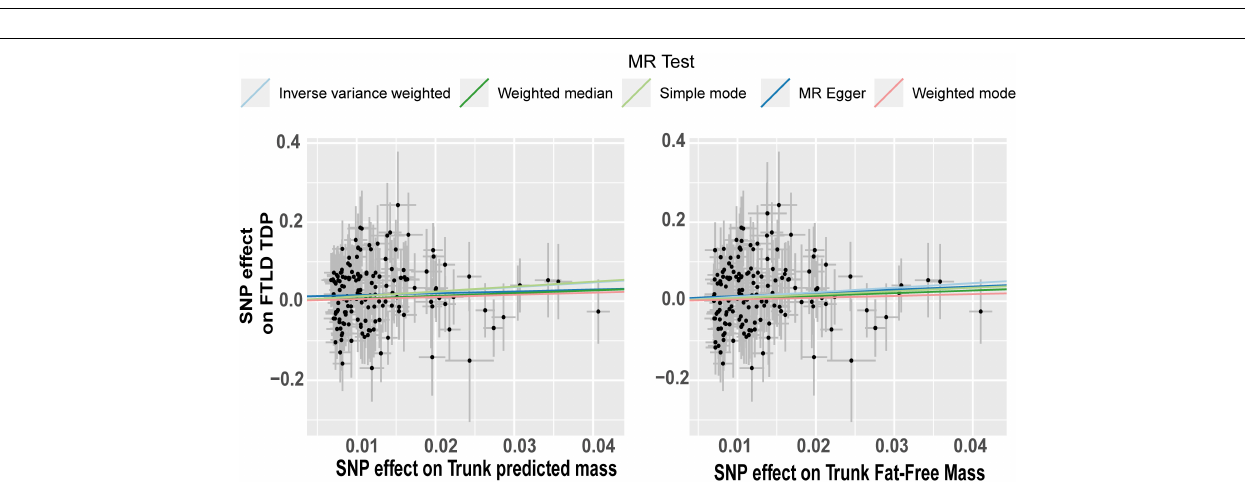
FIGURE 4 | Odds ratio (OR) and forest plot for the causal association with the risk of ALS by, (A) body composition and, (B) circulating lipids. BMI, body mass index, BF%, body fat percentage, CI, confidence interval, IVW, inverse variance weighted, SNPs, single nucleotide polymorphisms.